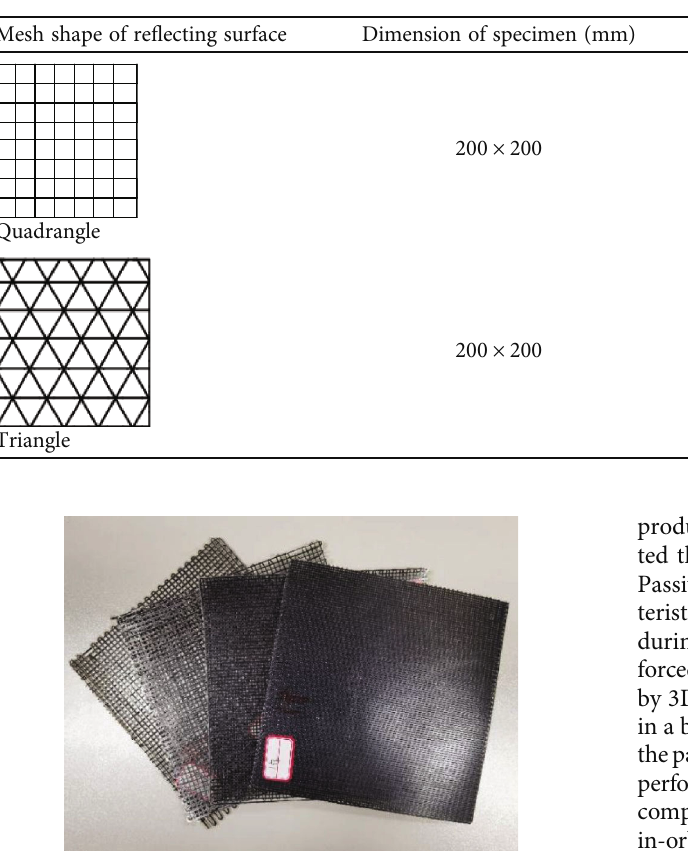
Figure 3: Continuous fi berreinforcedthermoplasticcompositemesh re fl ector specimen based on additive manufacturing